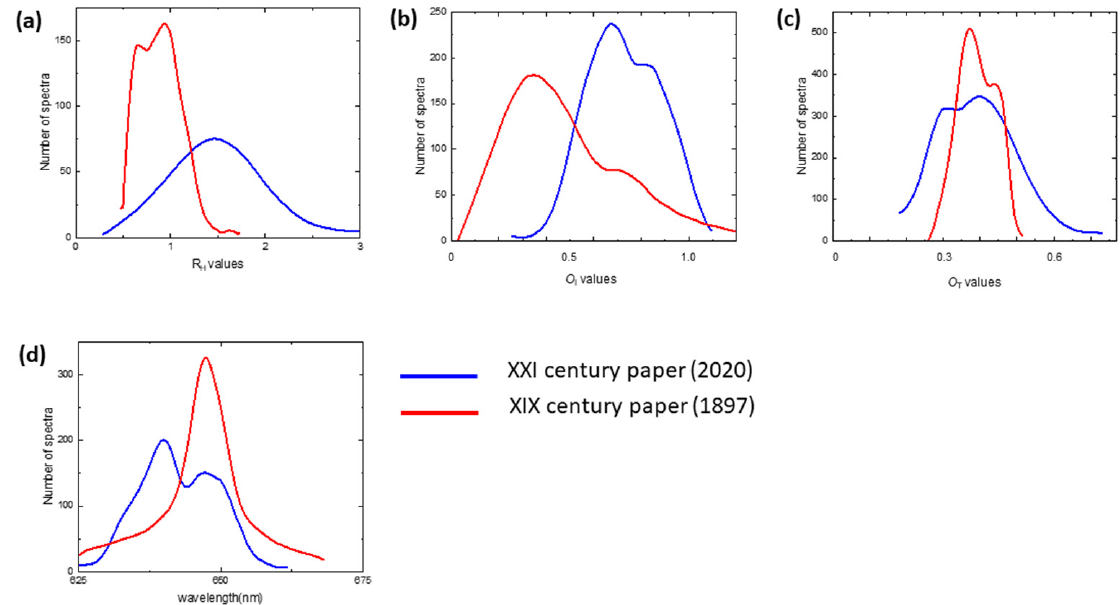
Figure 9. Distributions of ( a ) R H , ( b ) O I and ( c ) O T values from Raman spectra together with ( d ) the distribution of wp from luminescence spectra for XXI and XIX century paper.